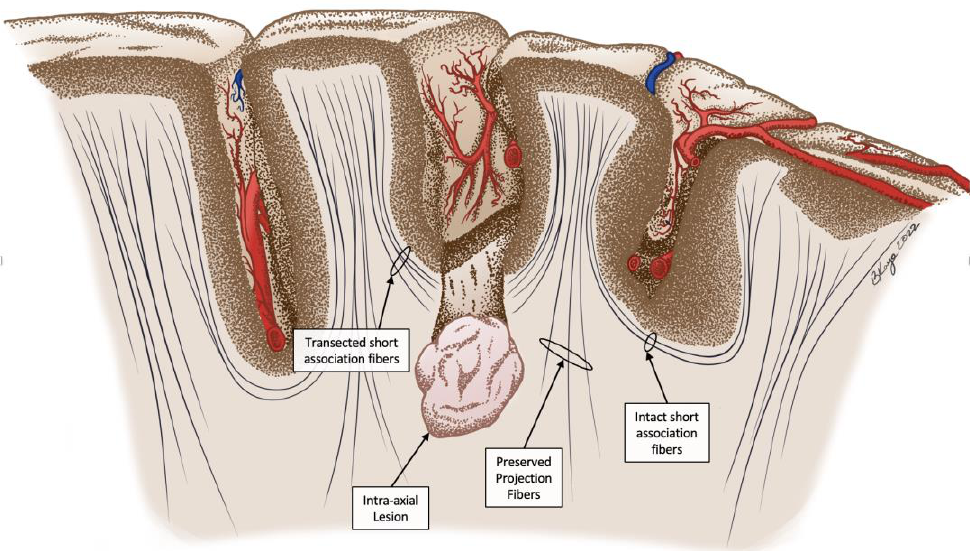
Figure 1. Illustration demonstrating an overview of the trans-sulcal approach employed for these subjects. A small cortectomy at the floor of the sulcus with transgression of the underlying short association fibers to reach the intra-axial lesion is shown. Preservation of gyral cortex and the projection fibers that coarse alongside the lesion is intended to preserve neurological function.